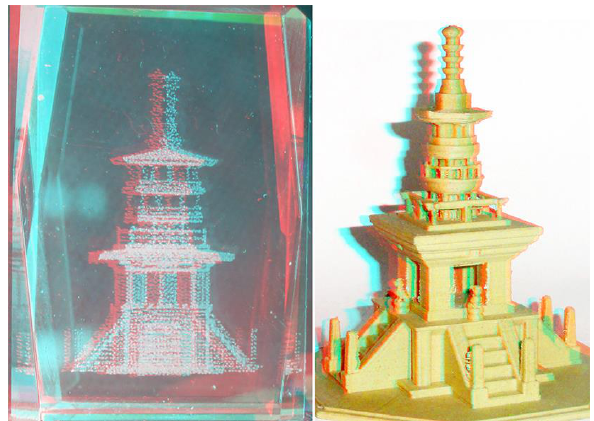
Figure 12. 3D photograph of the original of the famous Buddhistic Bulgugsa Dabotap pagoda of the former Silla Kingdom near Geongju (South Korea) (dated approx. from AD 751)